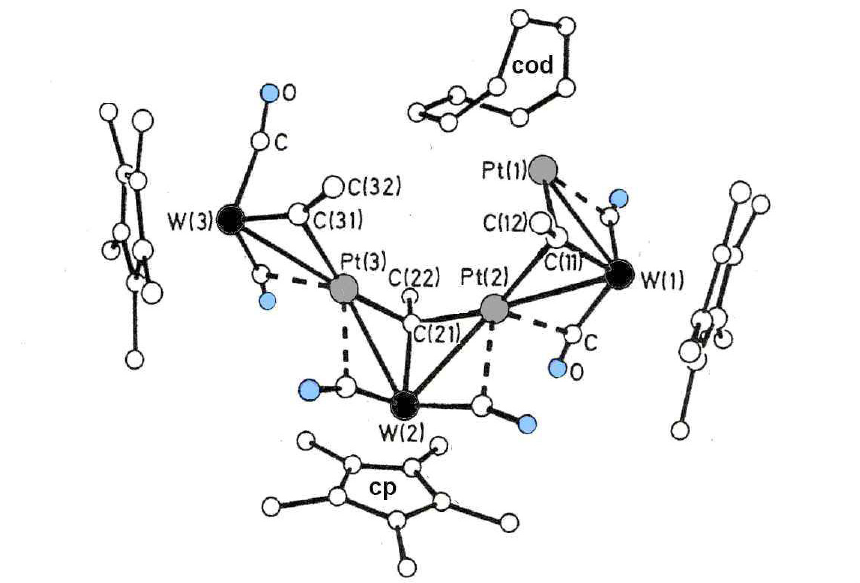
Figure 2. Structure of [Pt